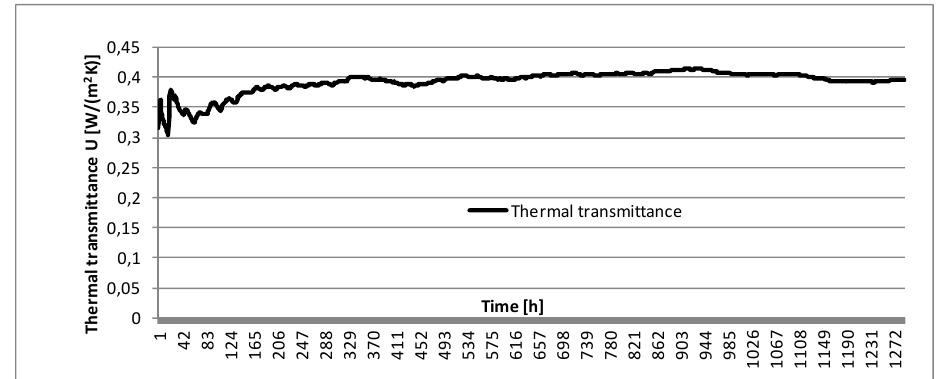
Figure 18. Thermal transmittance coefficient U for the wall insulated with recycling panels.